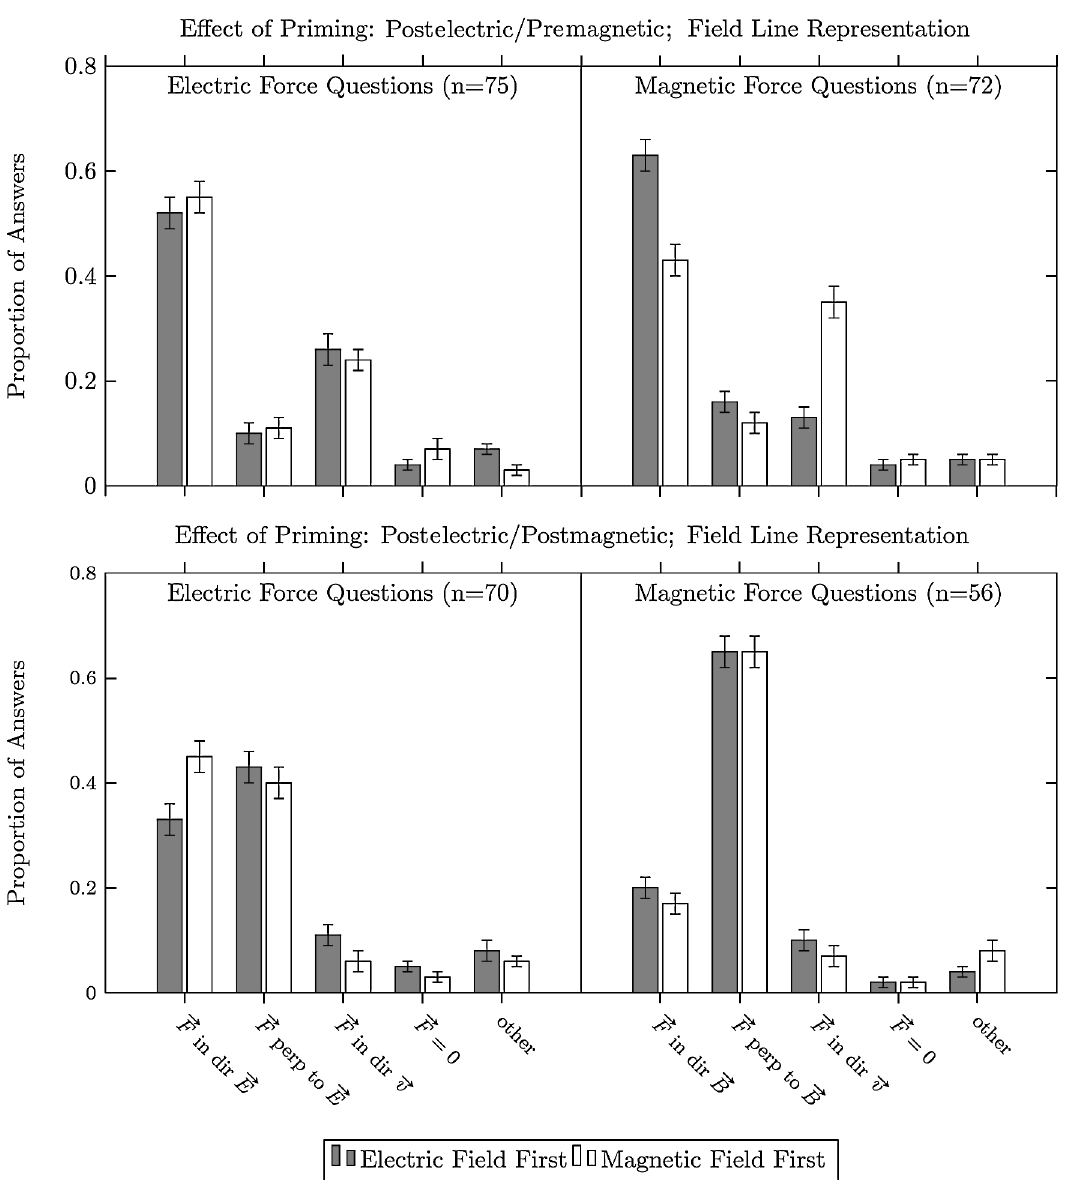
FIG. 7. Student responses showing the effect of question order (or cognitive priming ) on the field line representation.